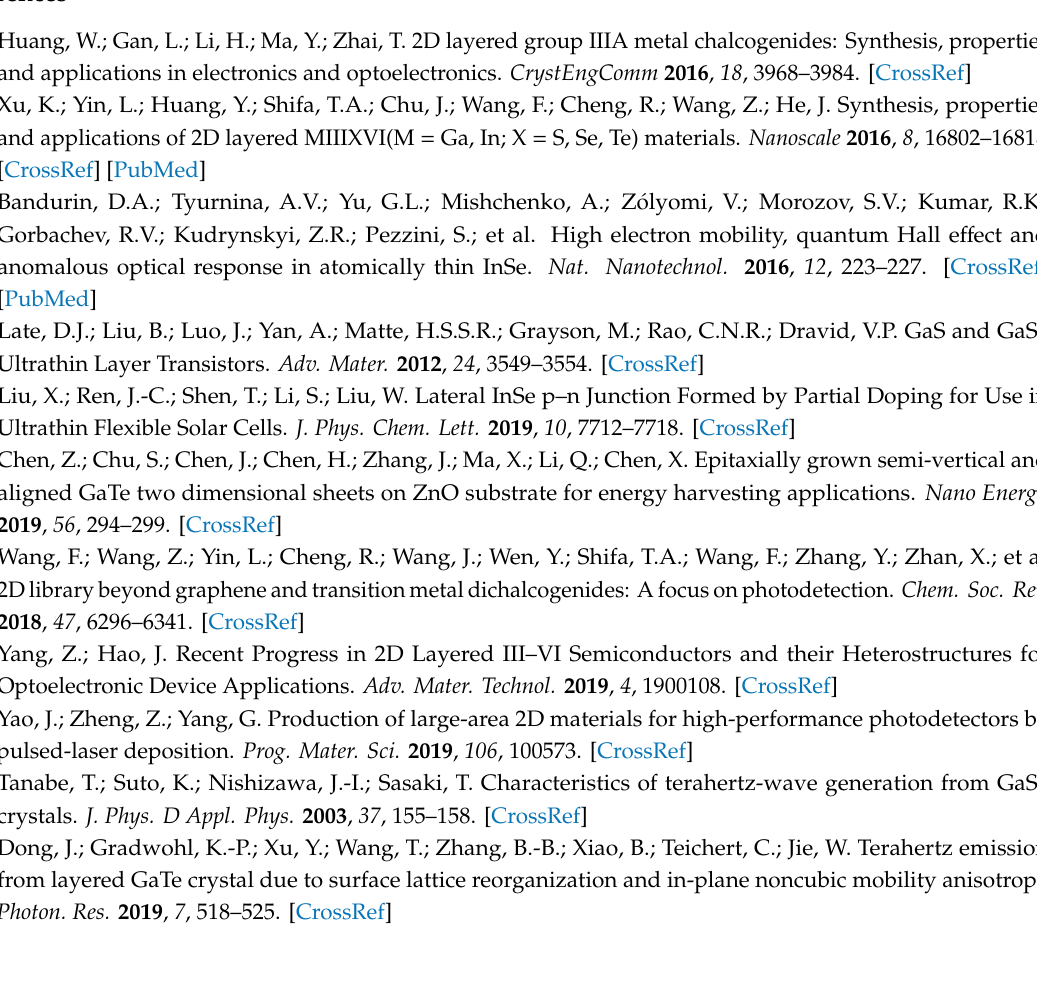
HQ Graphene—curve 1. Typical Raman spectra of γ -GaSe layers grown on GaAs(001) and GaAs(112) substrates at T S ~ 400 ◦ C (Curves 2 and 3, respectively). All spectra are normalized to the intensity of the A 1 (132 cm − 1 ) phonon line, Figure S6: Photoluminescence spectrum of the InSe / GaAs(001) layer measured at T = 11 K. The spectrum is most accurately approximated by four Gaussian contours centered at 1.315, 1.301, 1.28, and 1.2 eV, respectively, Figure S7: The plan-view SEM image of the InSe / GaSe / GaAs(001) structure. The growth temperature of InSe layer was as high as T S ~ 450 ◦ C, Figure S8: PL spectra of the GaTe / GaAs(001) layers #GT1 and #GT2 measured at the same excitation power density of 0.5 W / cm 2